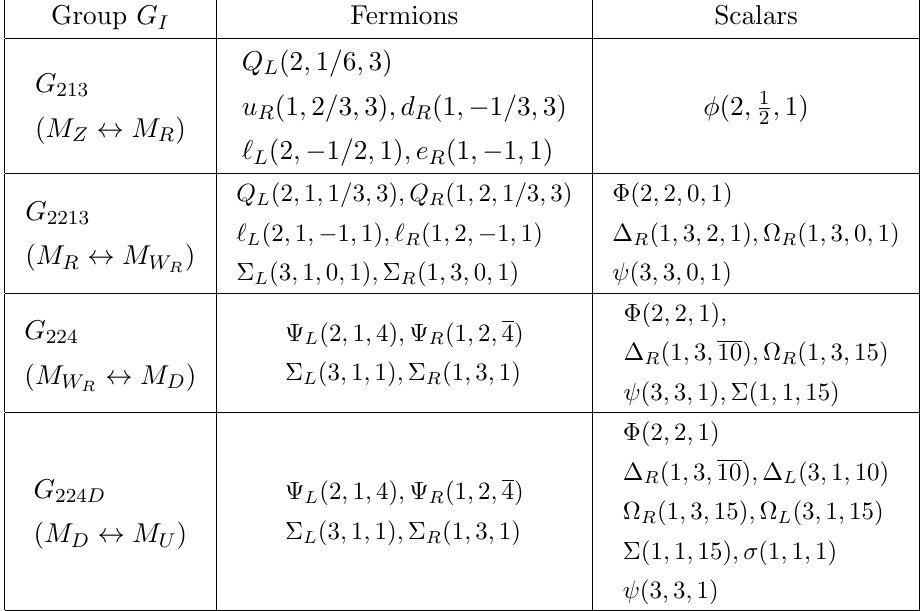
Table 3 . Fermions and Scalars at di(cid:11)erent stages of symmetry breaking scales i.e, in the mass range M Z M R , M R M W , M W M D and M D M U . Here M Z is the SM Z boson mass, M R is the R R (cid:0) (cid:0) (cid:0) (cid:0) scale at which left-right symmetry breaks and M W is the scale at which Pati-Salam symmetry is R broken down. In our numerical analysis, we consider both left-right symmetry breaking scale is very close to Pati-Salam symmetry breaking scale and thus, its e(cid:11)ect in RG analysis is not accounted for simplicity. We also kept left-handed fermion triplet at few TeV scale while right-handed fermion triplet at few PeV scale. The one-loop beta coe(cid:14)cients derived in the mass range M W M D as R (cid:0) b i = 2 = 3 ; 33 = 3 ; 13 = 3 and for M D M U as b i = 33 = 3 ; 33 = 3 ; 2 = 3 by taking (3 ; 3 ; 1), (3 ; 1 ; 15) f(cid:0) (cid:0) g (cid:0) f g and (1 ; 3 ; 15) as real